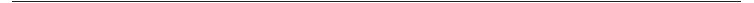
Table 1. List of drugs that induced cellular responses. Median-effect values were fitted to the scores in Figure 1 using the equation in the Methods. The table lists D the column number of half effect for the drug rows marked by m arrows in Figure 1. The higher the D number is, the more effective the drug m is at higher dilutions. The corresponding concentration for a specific drug is